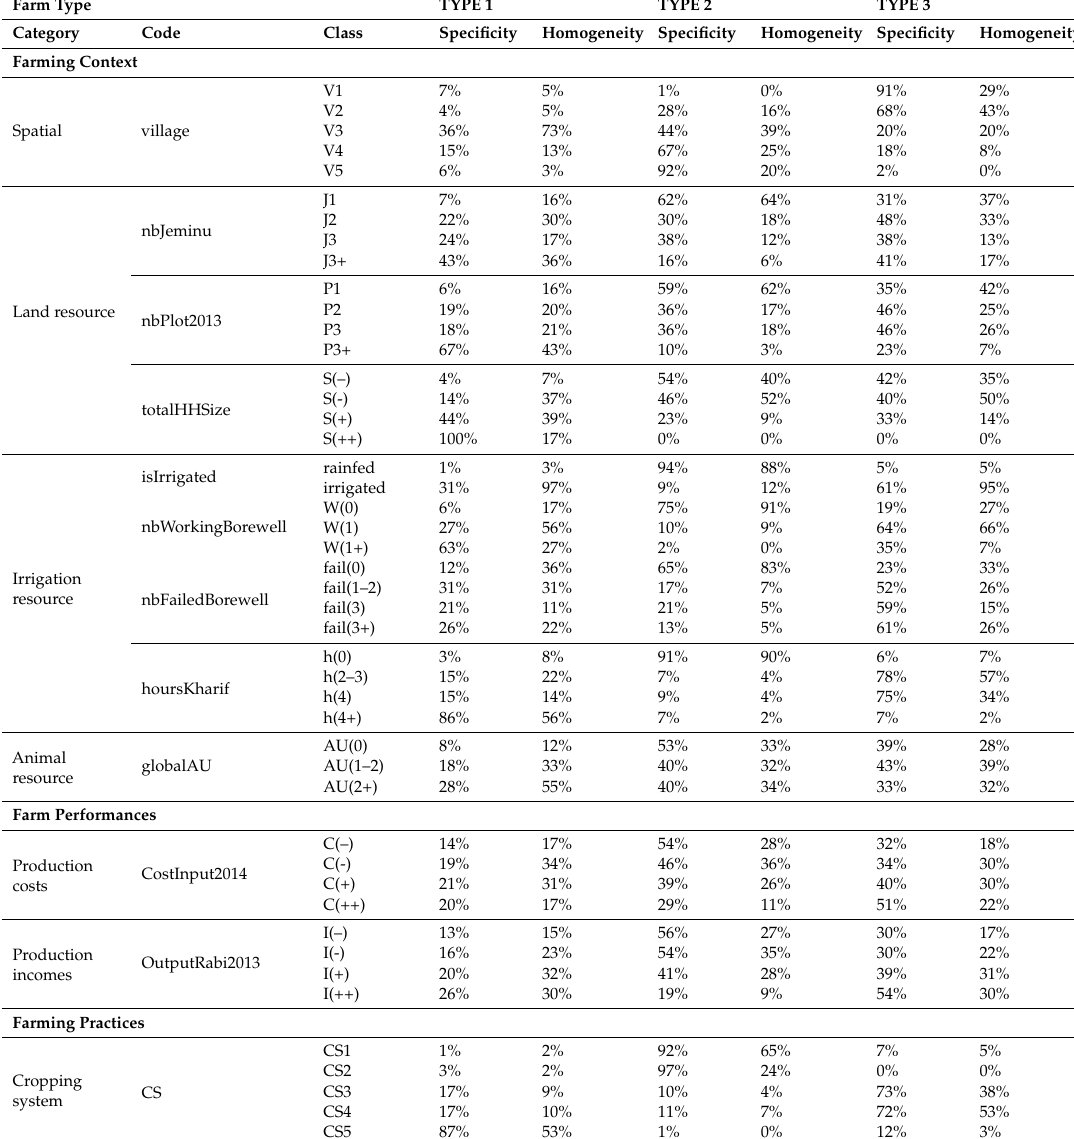
Table 2. Specificities and homogeneities of the farm